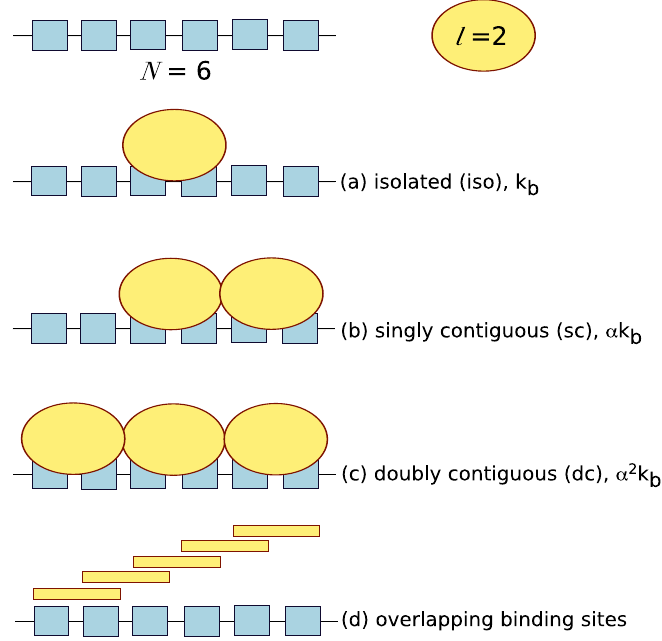
Figure 3. The three distinguishable types of ligand binding sites: isolated (iso), singly contiguous (sc) and doubly contiguous (dc). The potential number of binding sites is given by ( N ¡ l + 1 ), so that in this example where N = 6 and l = 2 , there are five potential binding